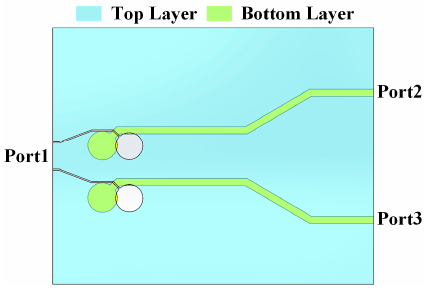
Figure 12. Layout of the ultra-wideband balun.